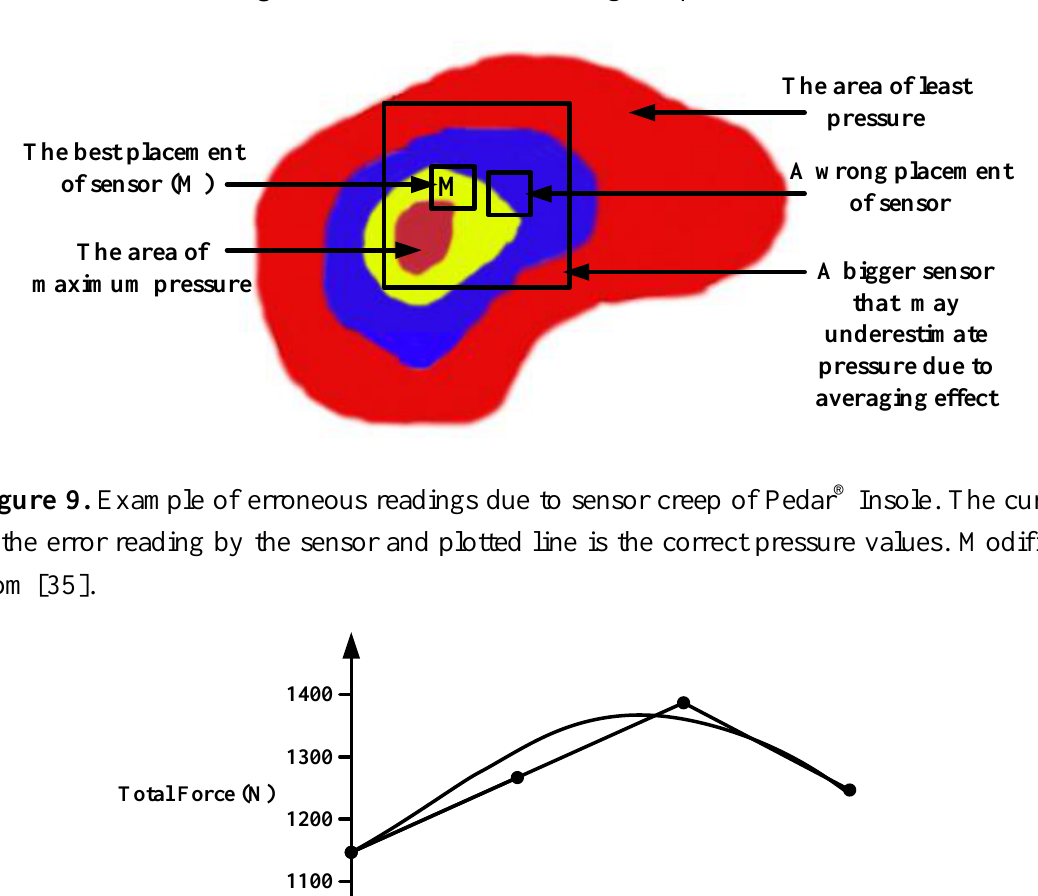
Figure 8. Effect of sensor sizing and placement.